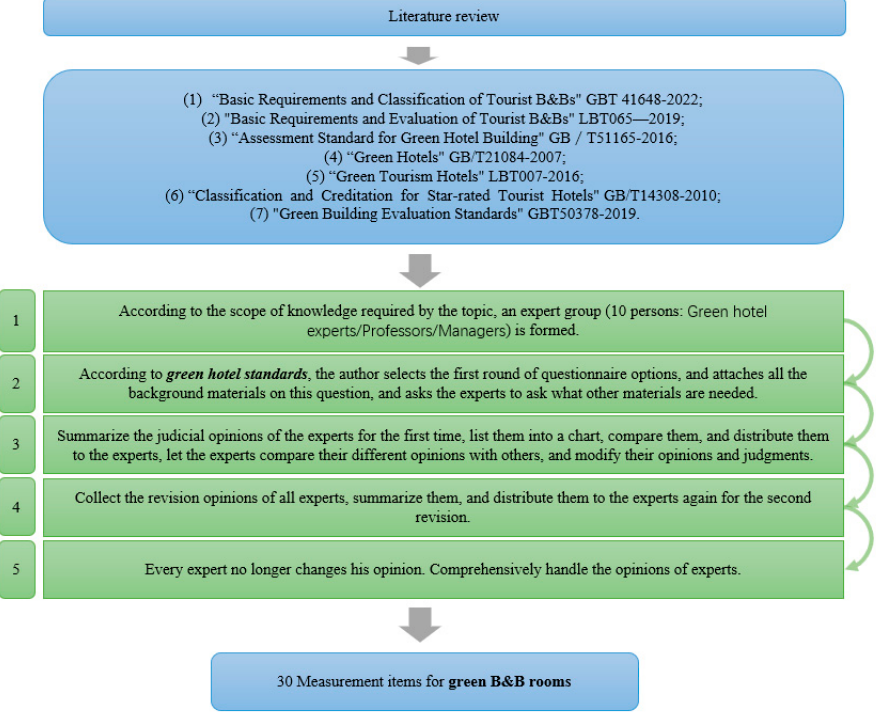
Figure 2. The design logic of the Delphi method and selection process of 30 research variables. Table 1. Measurement items for green B&B room.